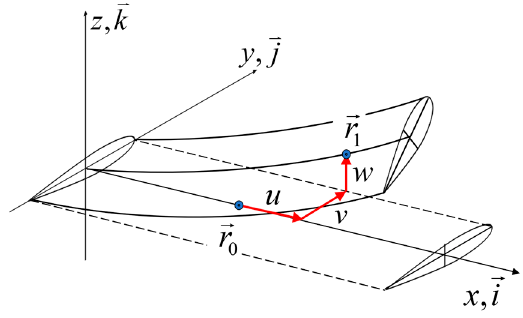
Figure 1. Definition of blade deformation.